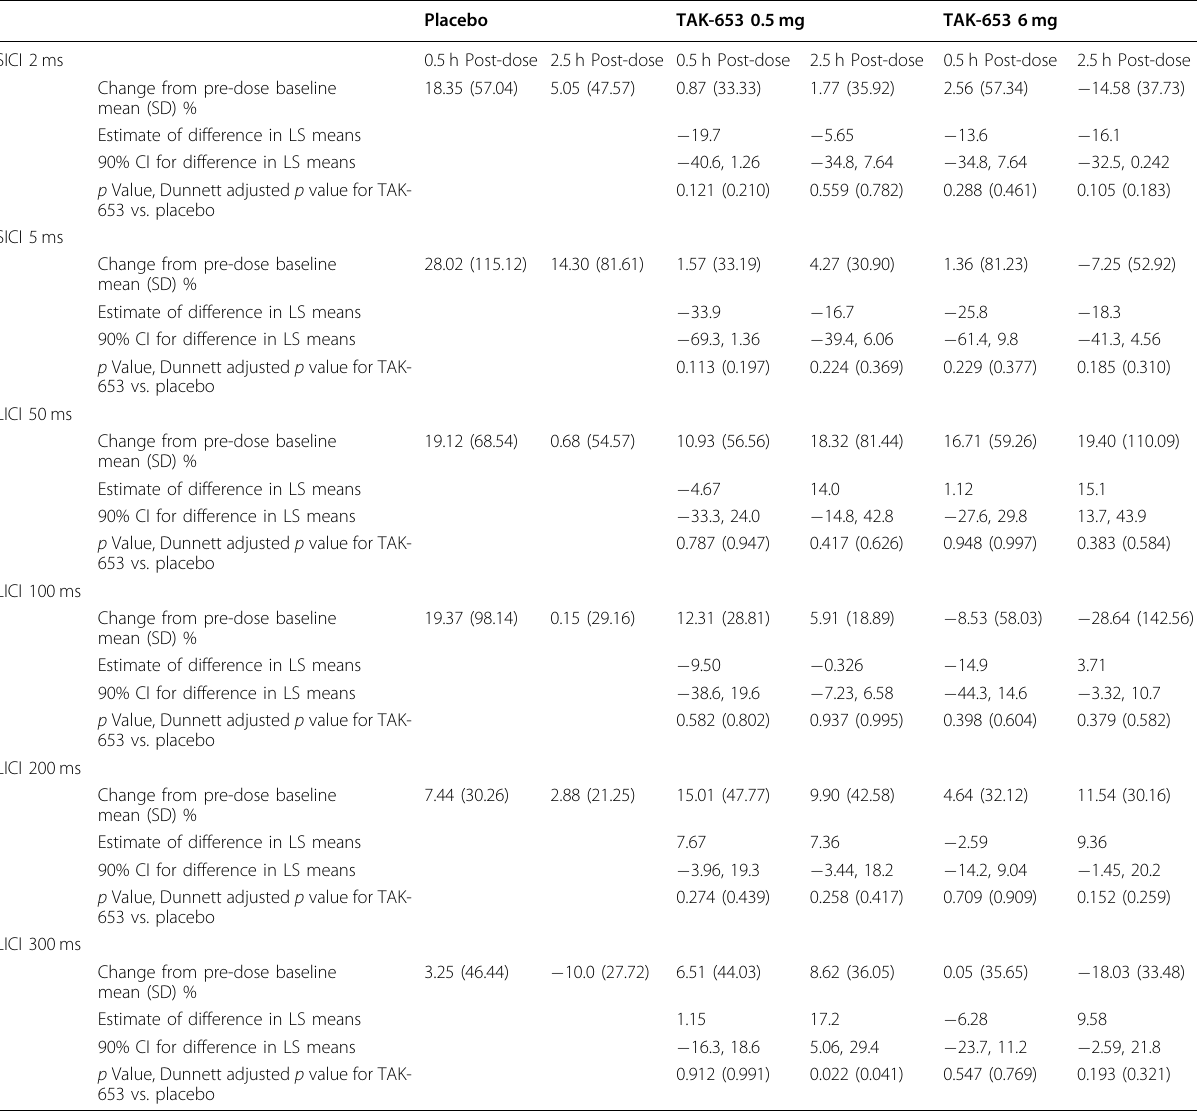
Table 5 Paired-pulse TMS was not affected by TAK-653 ( n = 24).